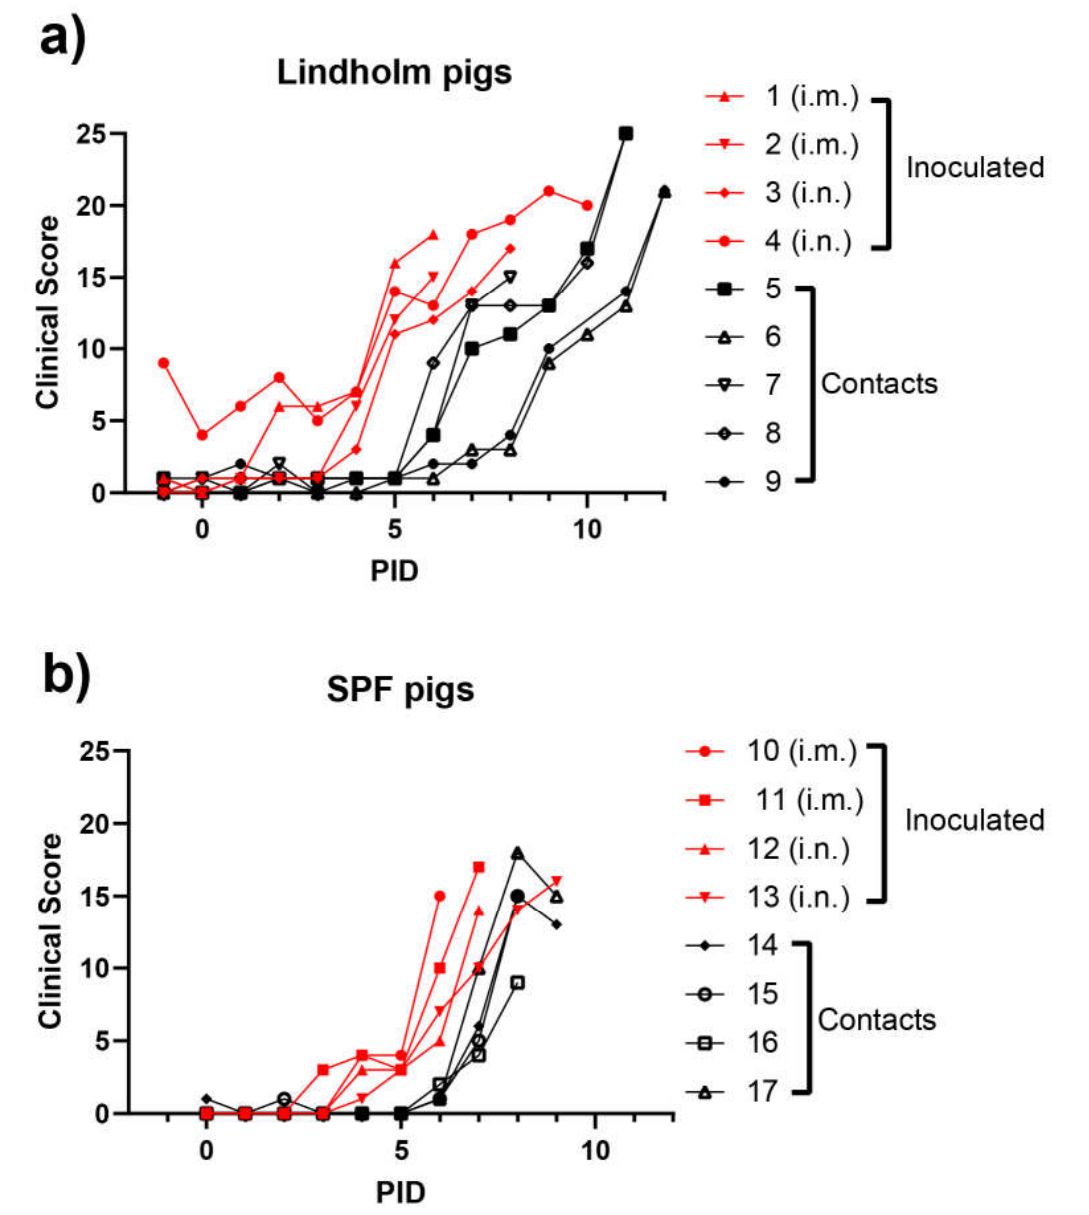
Figure 2. Clinical scores from ASFV-infected pigs using animals obtained from Lindholm’s herd ( a ) or from a commercial supplier of SPF pigs ( b ).